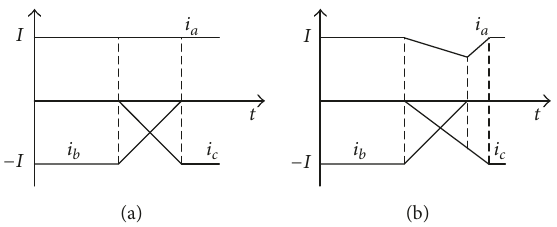
Figure 3: The commutation from 𝐵 -phase to 𝐶 -phase: (a) ideal case ( 𝑉 dc = 4𝐸 ); (b) actual case ( 𝑉 dc < 4𝐸 ).